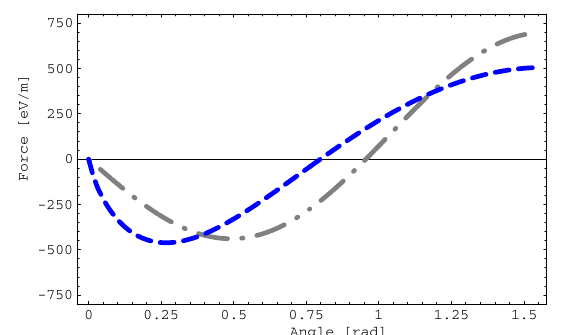
FIG. 8. (Color) Transverse component of the force at ion veloc- (cid:5) 1 : 1 (cid:6) 10 7 m = s , (cid:1) (cid:5) 1 : 0 (cid:6) 10 5 m = s , ity 3 (cid:6) 10 5 m = s ( (cid:1) e; ? e; k B (cid:5) 5 T ): gray dot-dashed line—Eq. (6); blue dashed line— Eq. (4).